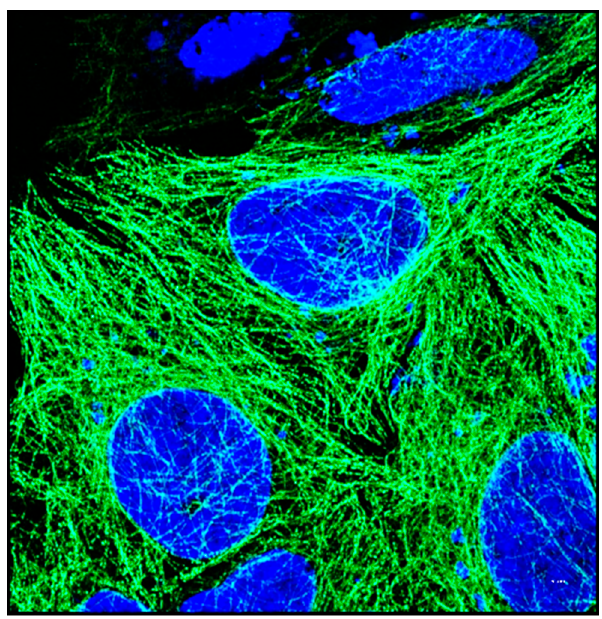
Figure 5. Structure of tubulin. Immunofluorescent image of HeLa cells showing tubulin (primary antibody labelled with Alexa 488 secondary antibody) surrounding a group of cells. Nucleus is shown in blue. Image was taken using airy scan mode in Zeiss 800 confocal microscope using 63× objective. Scale bar = 5 µm.